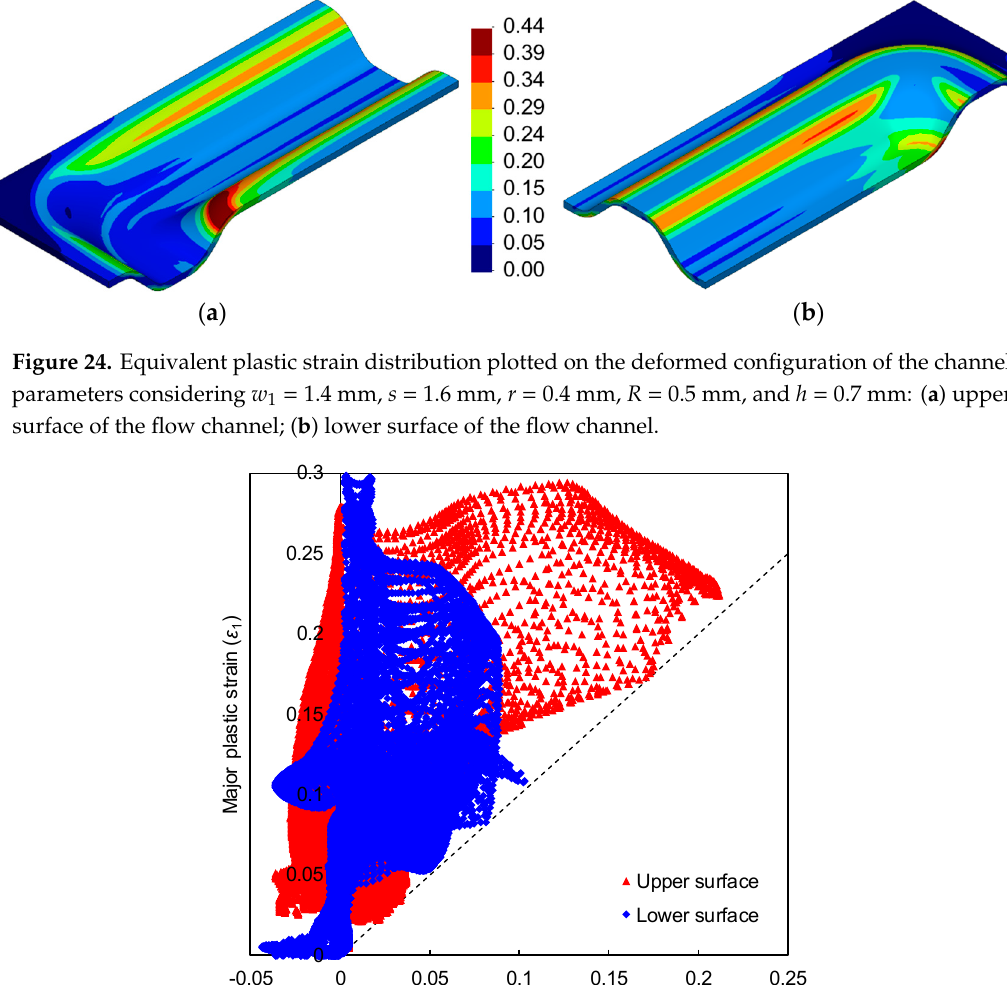
Figure 24. Equivalent plastic strain distribution plotted on the deformed configuration of the channel parameters considering w 1 = 1.4 mm, s = 1.6 mm, r = 0.4 mm, R = 0.5 mm, and h = 0.7 mm: ( a ) upper surface of the flow channel; ( b ) lower surface of the flow channel.